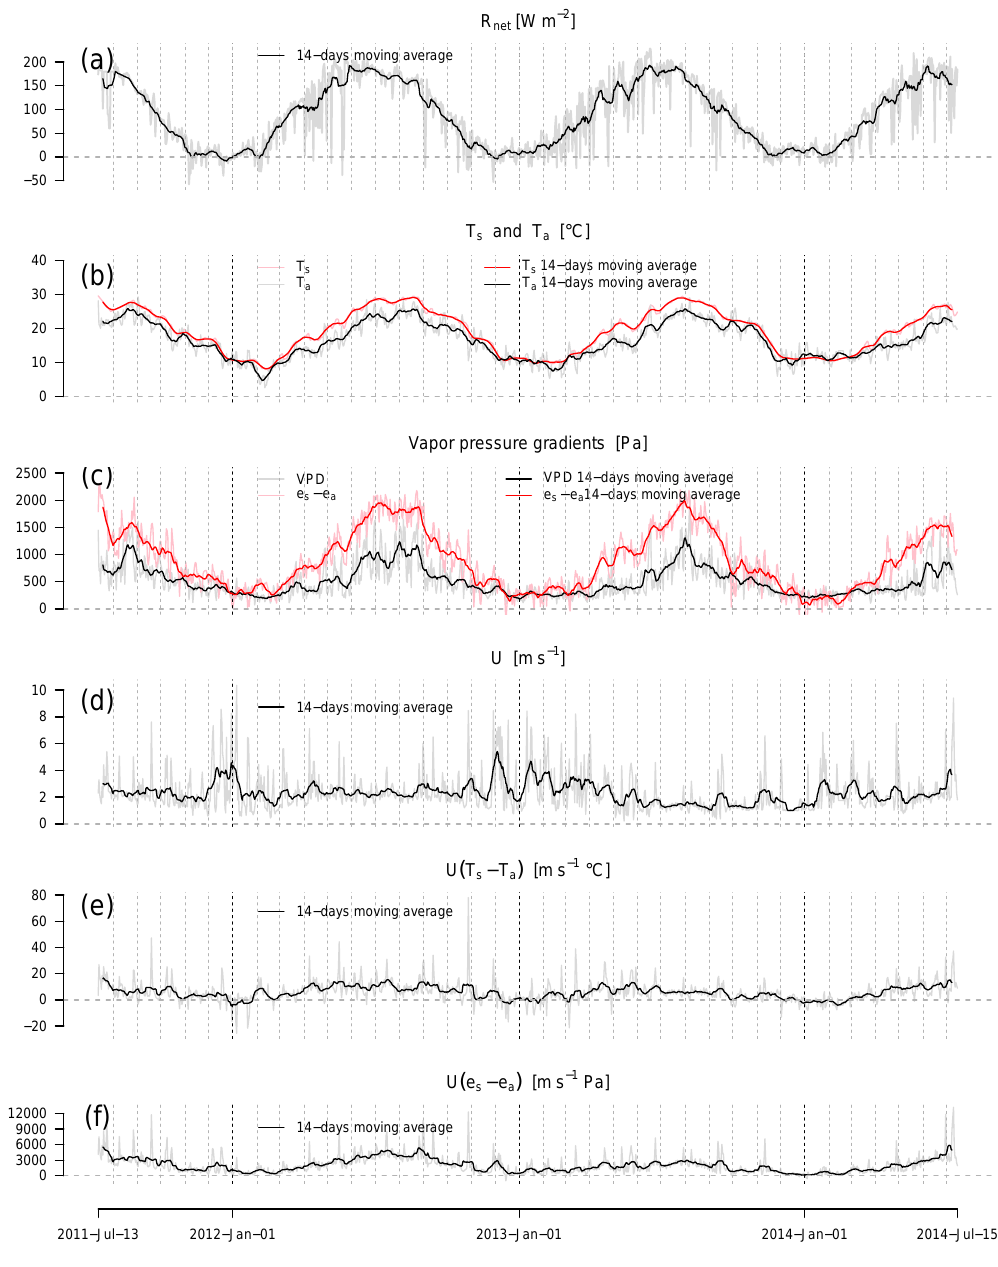
Figure 3. Time series of 14-day moving average (dark-colour lines) and mean daily (light-colour lines) of (a) net radiation, R net , (b) lake surface ( T s , red) and air ( T a , black) temperatures, (c) difference between saturated water vapour and water vapour in the atmosphere ( e s − e a , red) and vapour pressure deficit ( e a − RHe a , black), (d) wind speed U , (e) the product of wind speed with the difference between lake and air temperature U(T s − T a ) , and (f) the product of wind speed with the difference between saturated water vapour and air vapour pressure U(e s − e a ) .